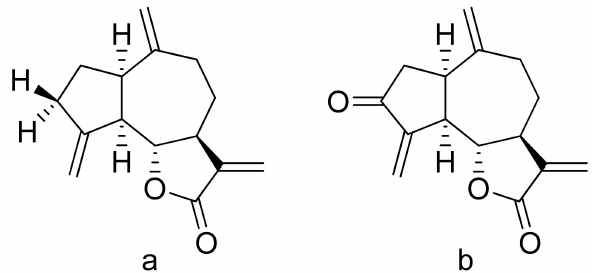
Figure 7. Lactones from the guajanolide class ( a , b